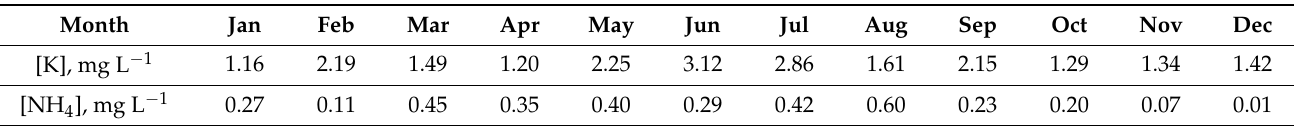
Table 2. Concentrations of ammonium [NH 4 ] and potassium [K] ions measured in the deep part of Sector 7 (see Figure 2b) from 07/2002 to